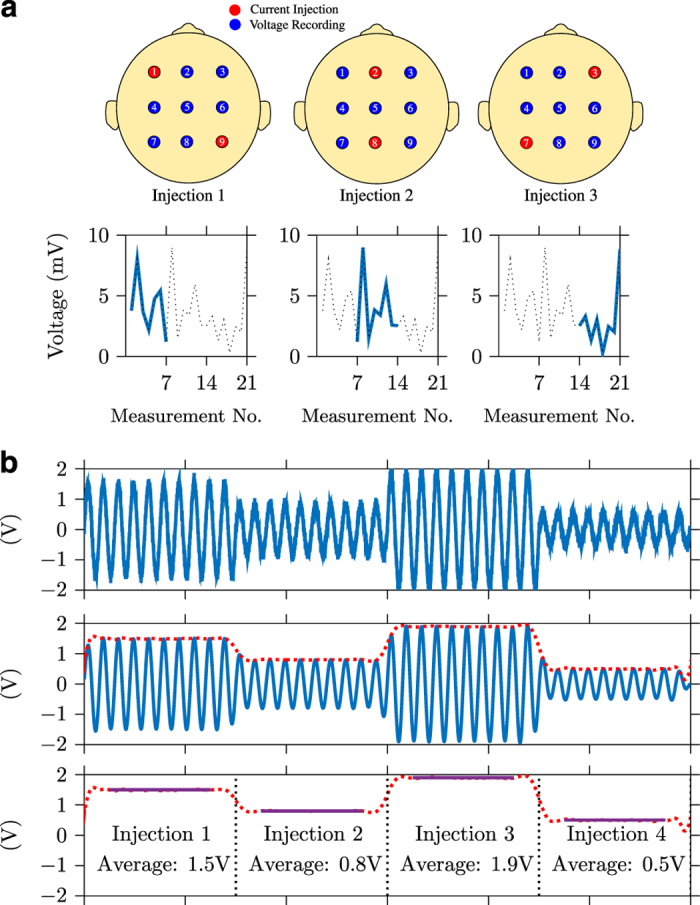
The EIT data collection and demodulation process.a Simplified EIT data collection with three current injection pairs out of nine total electrodes. For each injection pair, voltage recordings are made on the remaining seven electrodes, to produce a total of 21 measurements in this example. b Data processing pipeline on a single electrode in this example for four different injection pairs. Top: Raw data are imported from BioSemi bdf file, middle: filtering around the injection frequency and demodulation using the Hilbert transform (red line), bottom: segmentation into individual injections and averaging. The edges of the the waveform are excluded from averaging to remove switching and filtering artefacts.